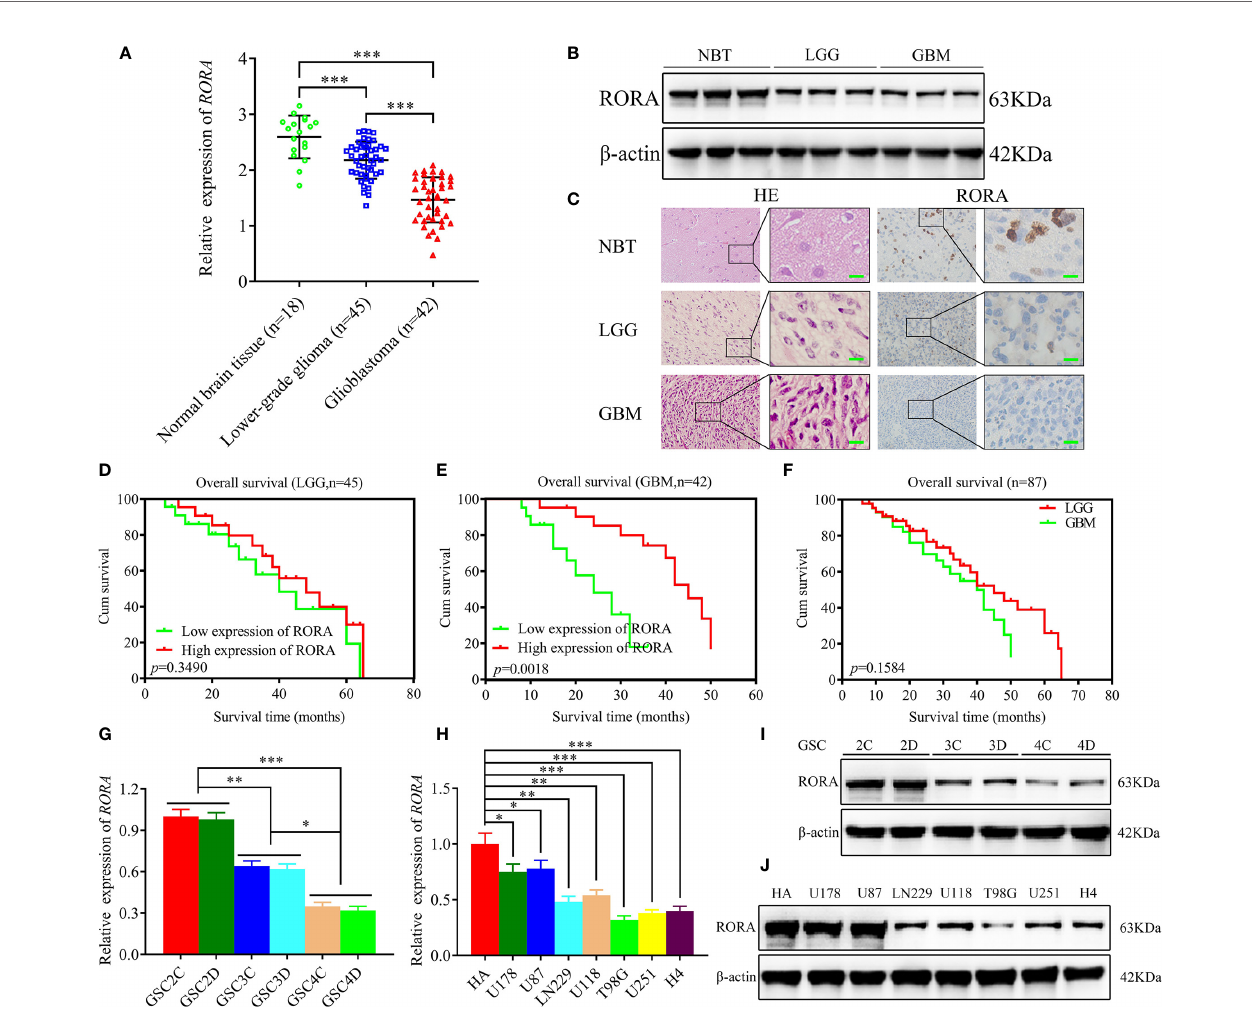
FIGURE 1 | Retinoic acid receptor-related orphan receptor A (RORA) has low expression in glioblastomas and correlates with poorer patient survival, and the expression of RORA in patient-derived GSCs and GBM cell lines. (A – C) RT-qPCR (A) , western blotting (B) , and immunohistochemistry analyses (C) showing RORA expressions in different clinical glioma specimens, when compared with normal brain tissues (NBTs). b -actin was used as a loading control. (lower-grade glioma, LGG, n = 45; glioblastoma, GBM, n = 42; NBTs, n = 18; P < 0.001; one-way analysis of variance). Scale bar = 50 µm. (D – F) Kaplan-Meier analysis of 87 cases of glioma patients with high RORA expressions versus low RORA expressions. (G – J) RT-qPCR (G, H) and western blotting (I, J) showing RORA expression in six patient-derived GSCs and in GBM cell lines. All data are expressed as the mean ± SD (three independent experiments). *P < 0.05; **P < 0.01; ***P <